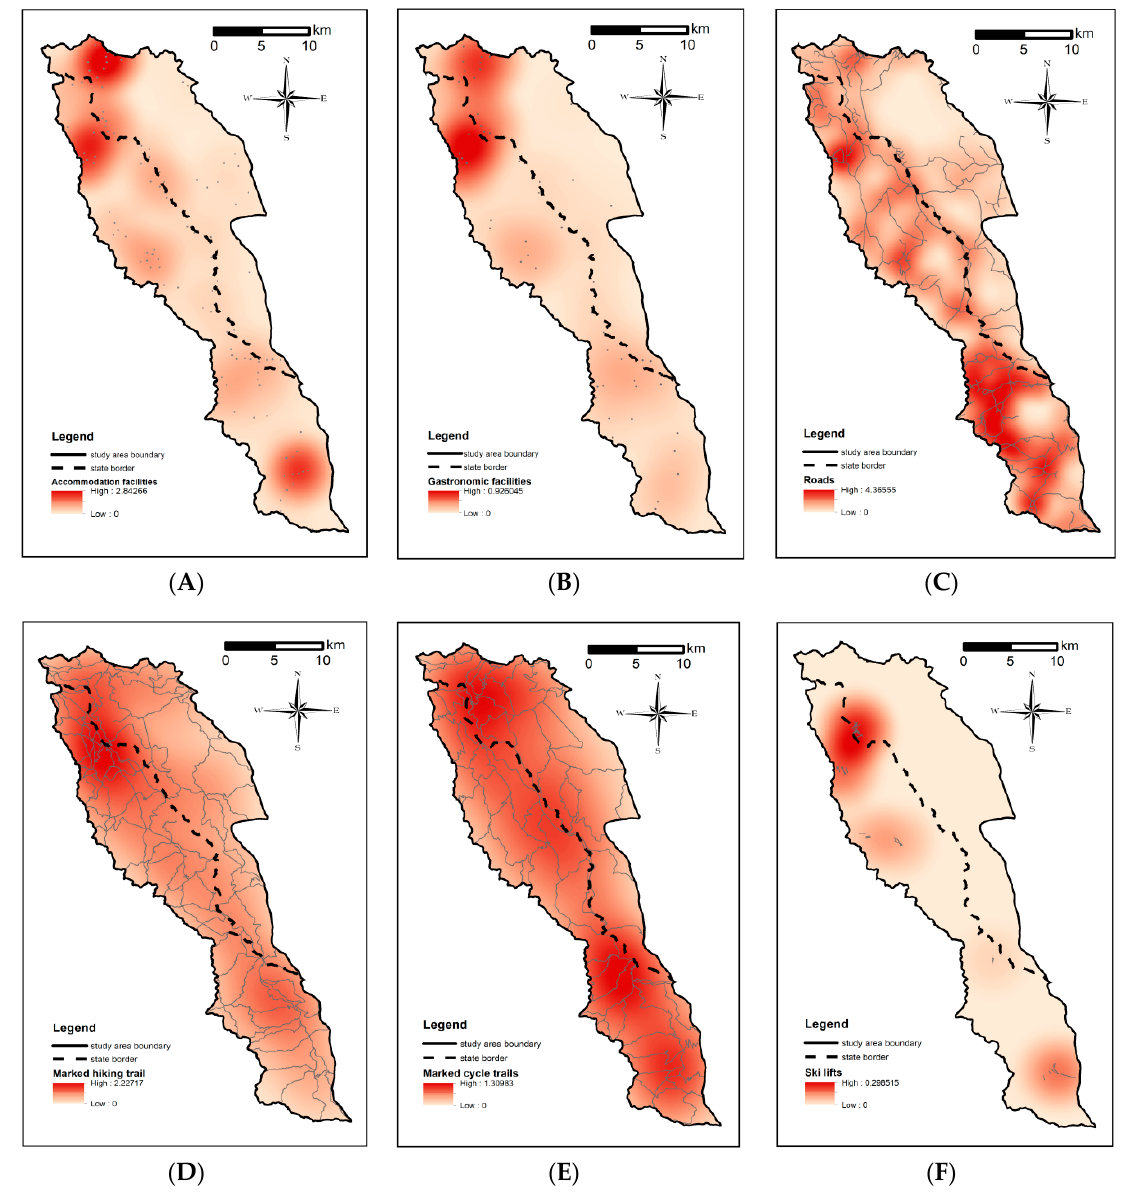
Figure 6. Hotspot analysis of the selected tourism infrastructure in the study area using the kernel density estimator (KDE) method: ( A ) accommodation facilities; ( B ) gastronomic facilities; ( C ) roads; ( D ) marked hiking trails; ( E ) marked cycle trails; ( F ) ski lifts. Source: authors’ own research.